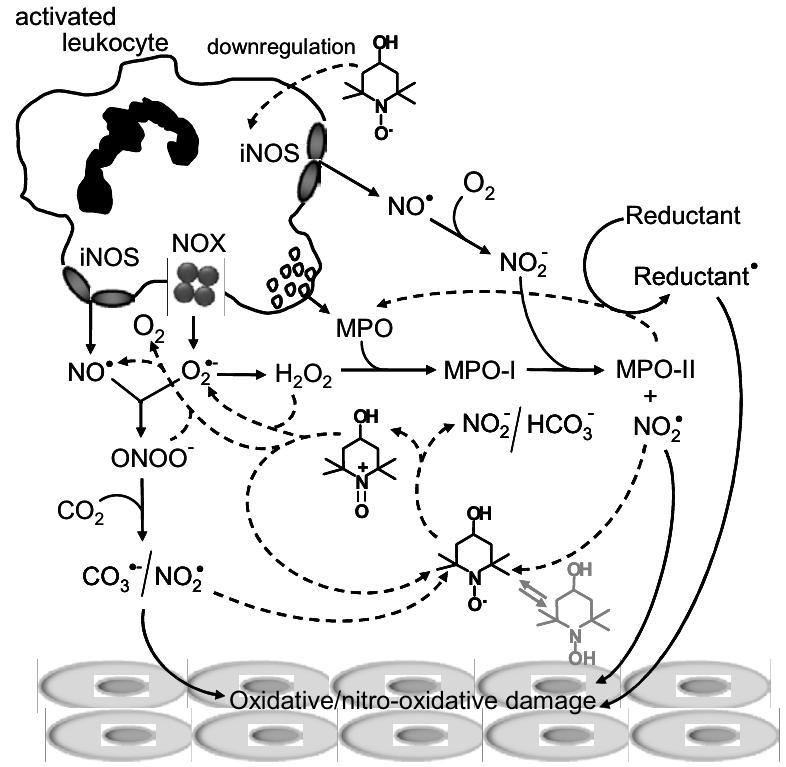
Fig. 4 – Schematic representation of sources of nitric oxide-derived oxidants and tempol effects/reactions proposed to attenuate tissue injury in inflammatory conditions. The scheme presents an extremely simplified overview where the nitric oxide is produced by activated leukocytes hypothetically expressing iNOS, and NOX (phagocyte oxidase) and liberating MPO. Other possibilities, such as expression of COX-2, are omitted. The reactions are not balanced, intermediates are omitted for clarity and the possibility of the oxammonium cation (TPNO + ) being recycled by cellular reductants is omitted for lack of data (see text). The hydroxylamine-derivative (grey) is proposed to function as a reservoir of tempol but its reactions are not shown (see Fig. 1). Reactions downstream of nitric oxide and superoxide radicals leading to oxidants capable of promoting oxidative tissue damage are marked with full lines, whereas protective reactions are marked with interrupted